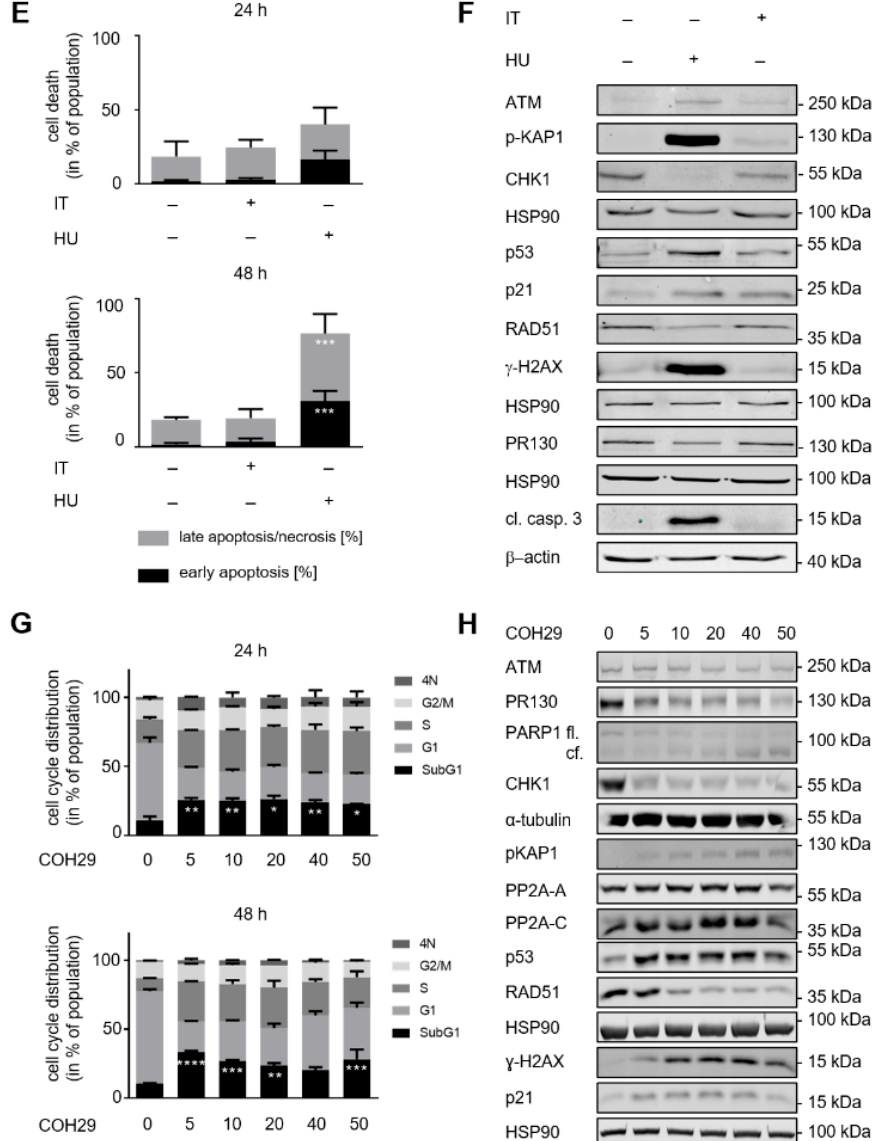
Figure 2. Hydroxyurea induces apoptosis and DNA damage in PDAC cell lines. PDAC cell lines were treated with irinotecan (IT) or hydroxyurea (HU). Cell cycle distributions and subG1 phases of ( A ) S821, ( B ) 8296, ( C ) 8248, and ( D ) S411 cells after incubation with 2, 5, and 10 µ M irinotecan for 24 h and 48 h. The data were collected by flow cytometry of PI-stained cells and are shown as mean ± SD ( n = 3; one-way ANOVA, * p < 0.05, ** p < 0.01, *** p < 0.001, **** p < 0.0001). The first p -values refer to G1 phase, the second p -values to G2/M phase. ( E ) Apoptosis analysis of S411 cells that were treated with 5 µ M irinotecan or 1 mM hydroxyurea for 24 h and 48 h. Results were determined by flow cytometry by using annexin-V-FITC staining and are shown as mean ± SD ( n = 3). Hydroxyurea induces significantly higher levels of apoptosis than irinotecan (apoptosis: 31% ( p = 0.0005), late apoptosis/necrosis: 45% ( p = 0.0005). Statistical analysis was done with two-way ANOVA (* p < 0.05, ** p < 0.01, *** p < 0.001, **** p < 0.0001). ( F ) S411 cells were treated with 5 µ M irinotecan or 1 mM hydroxyurea for 24 h. The levels of ATM, p53, p21, RAD51, cleaved caspase-3 (cl. casp. 3) and PR130, as well as the phosphorylation of KAP1 and H2AX were measured by immunoblot. HSP90 and β -actin served as loading controls; n = 3. ( G ) A total of 5–50 µ M COH29 were applied to S411 cells for 24–48 h. Flow cytometry determined cell cycle distributions and cells in subG1 phase; n = 2. ( H ) S411 cells were treated with 5–50 µ M COH29 for 24 h. Immunoblot was done as indicated (fl., full-length PARP1; cf., cleaved form of PARP1). HSP90 and α -tubulin served as loading controls; n =